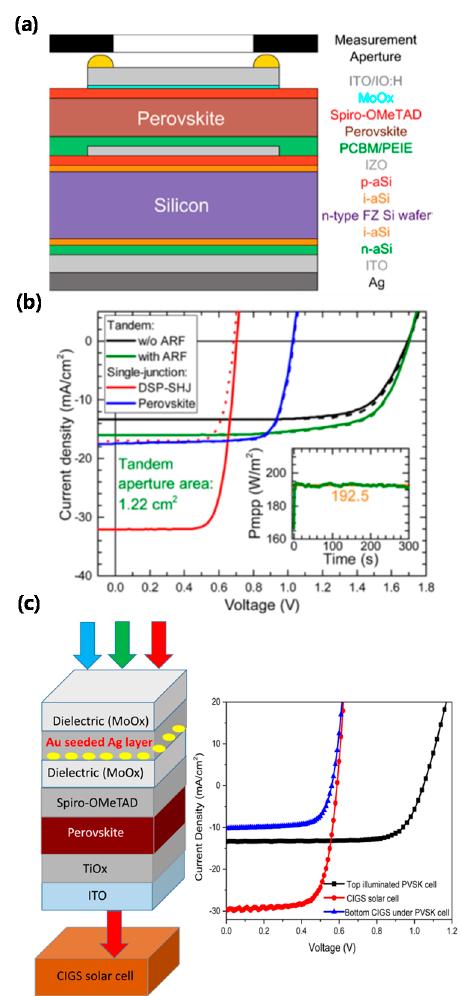
Figure 11. ( a ) Schematic drawing of a typical planar perovskite/Si heterojunction tandem cell layer stack; ( b ) J - V curves of the best perovskite/Si tandem and of the single junction perovskite and Si cell. Reprinted with permission from [81]. Copyright 2016 ACS. ( c ) Device architecture of a typical perovskite/GIGS tandem cell and J - V curves of top illuminated perovskite, CIGS, and perovskite/CIGS tandem cell. Reprinted with permission from [83]. Copyright 2015 ACS.